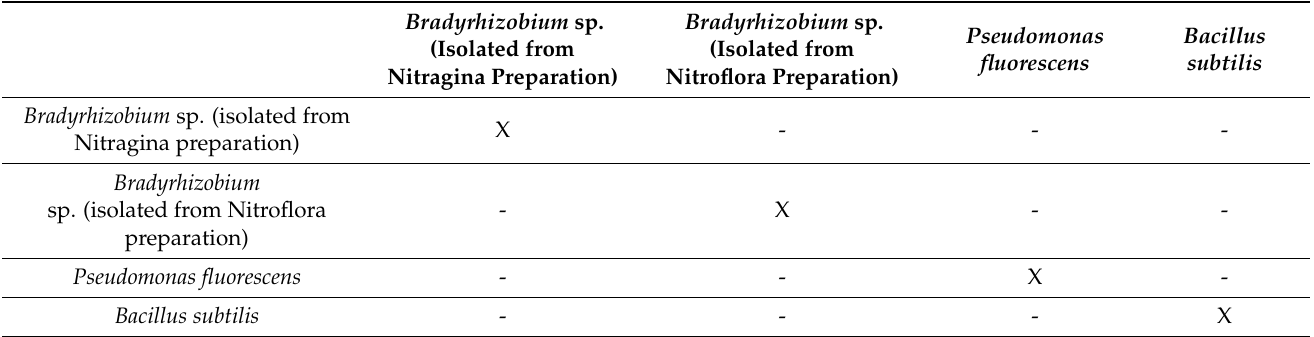
Figure 1. An example showing the effect of Pseudomonas fluorescens bacteria on bacteria of the Bradyrhizobium genus isolated from the Nitragina preparation. Saline was used as the control variant. Table 1. The interactions between the symbiotic bacteria ( Bradyrhizobium sp.) and endophytes ( Pseudomonas fluorescens or Bacillus subtilis